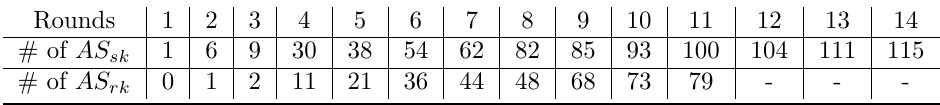
Table 6: The lower bound for the number of active S-boxes in the initialization phase where AS sk and AS rk mean an active S-box in the single-key setting and in the related-key setting,